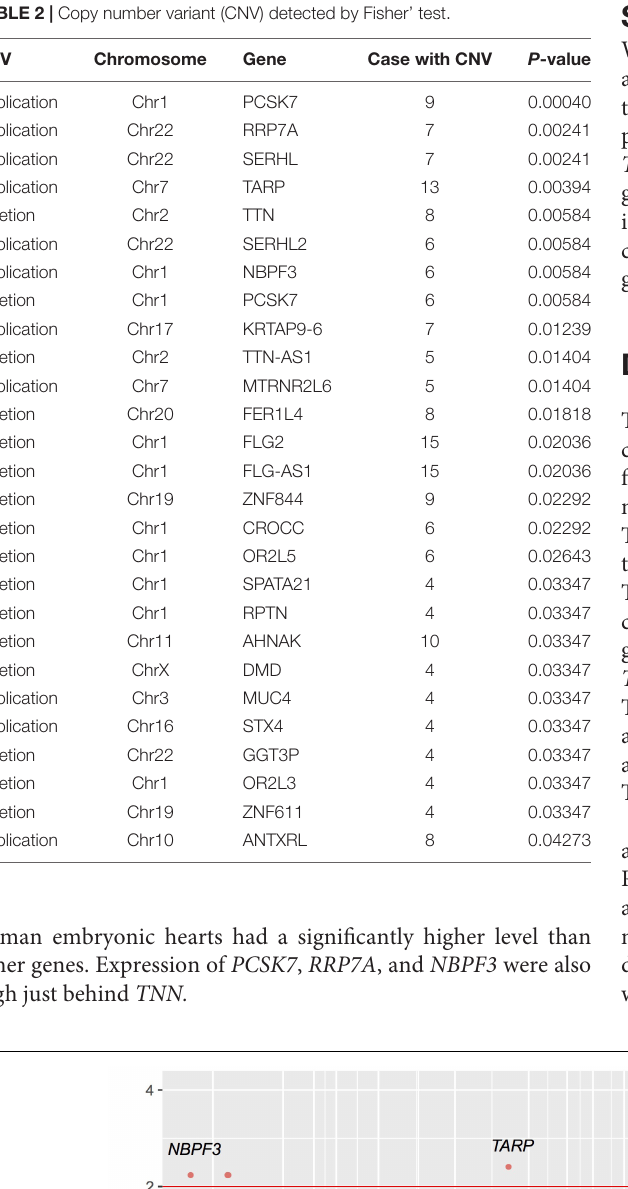
Frontiers in Genetics |